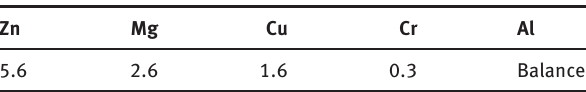
Table 2: Chemical composition of A7075 used in infiltration tests (wt.%).